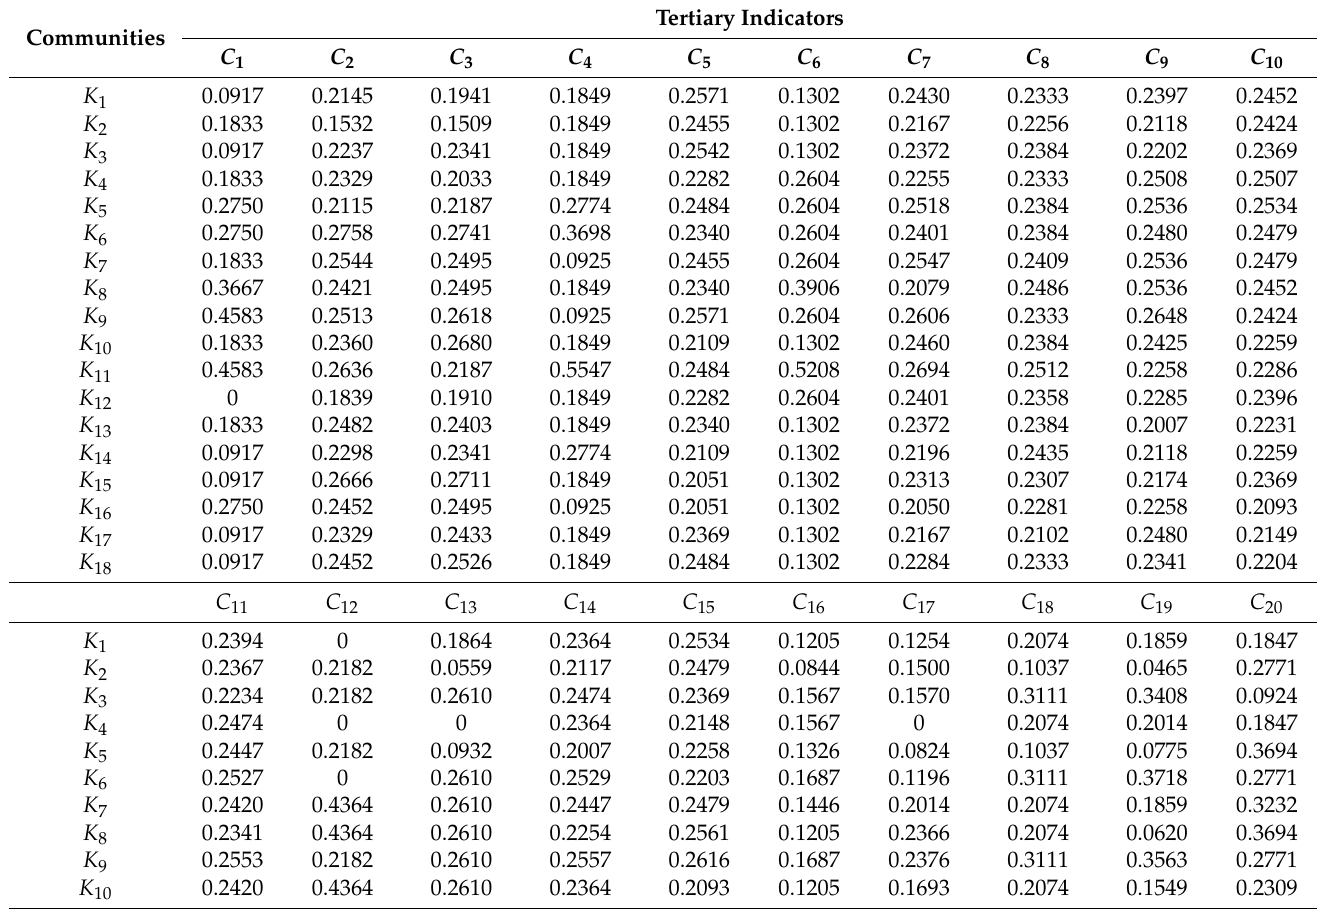
Table 6. The standardization matrix of Z